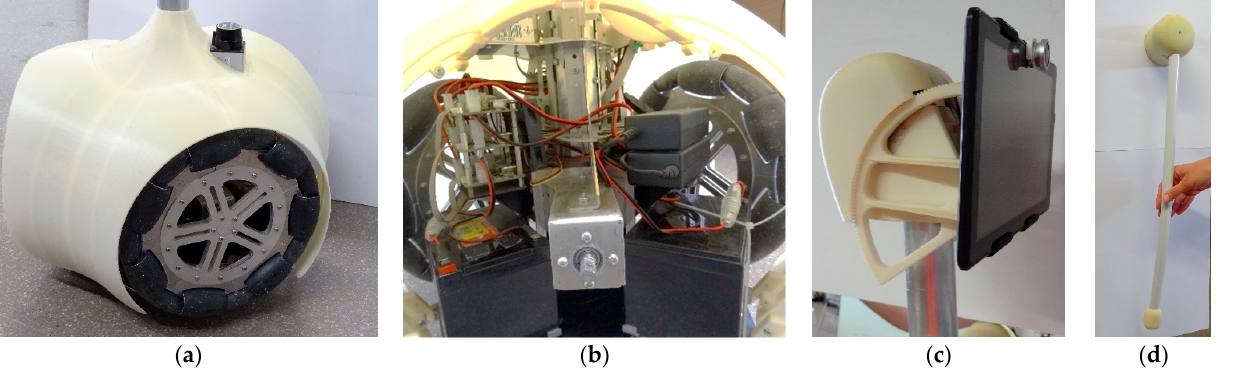
Figure 2. Close view of the APR-01 mobile robot prototype: ( a ) detail of the base of the robot containing the omnidirectional wheels, the characteristic ABS cover, and a 2D low-cost LIDAR; ( b ) detail of the interior of the base containing three lead batteries, the DC motors of the wheels, the battery chargers, and the main electronic board; ( c ) detail of the tablet located at the top of the robot and of the panoramic lens; and ( d ) detail of the arm used in walk-helper applications.